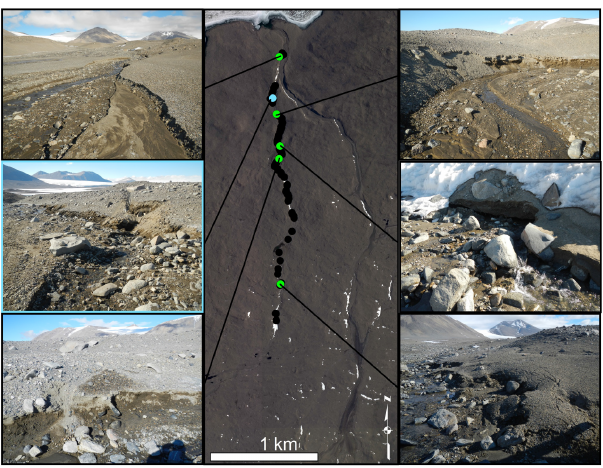
Figure 2. Map of images captured along the West Fork of Crescent Stream, as observed in January 2012, in which each black dot in- dicates a location at which a picture was taken, and the green dots indicate images from a few highlighted locations along the channel. Light blue highlighted image is of the entrance to the thermokarst tunnel on the east bank of the West Fork. Permafrost degradation features were observed along + 3km of the West Fork of Crescent Stream. Remote-sensing image provided by the Polar Geospatial Center, University of